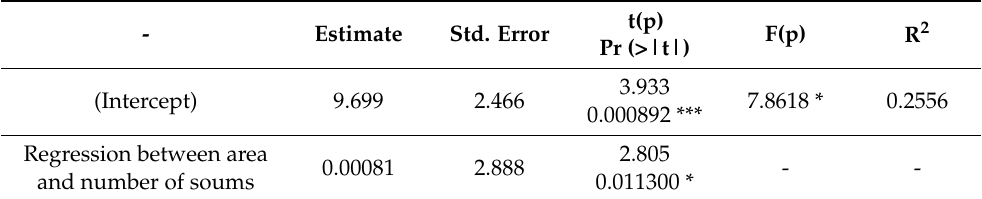
Table 7. Regression between area and number of